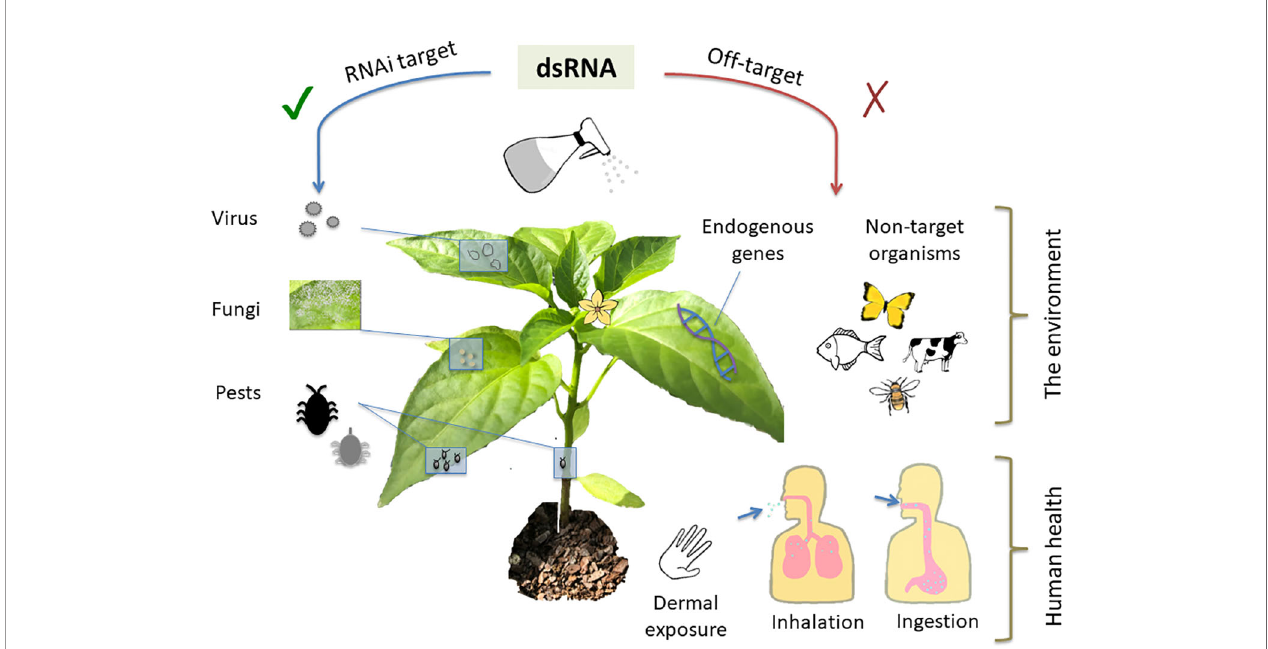
FIGURE 2 | As a crop protection measure, topically-applied dsRNA should be effective against speci fi c pests and pathogens while avoiding unintended adverse consequences. Topically applied double-stranded RNA (dsRNA) can be used to generate resistance to pathogenic viruses and fungi, and pests such as insects. Off- target impacts to be avoided include silencing of crucial host plant and other non-target organism genes. Potential routes of exposure to humans including operators applying the dsRNA along with consumers of treated products could occur via dermal exposure, inhalation, and